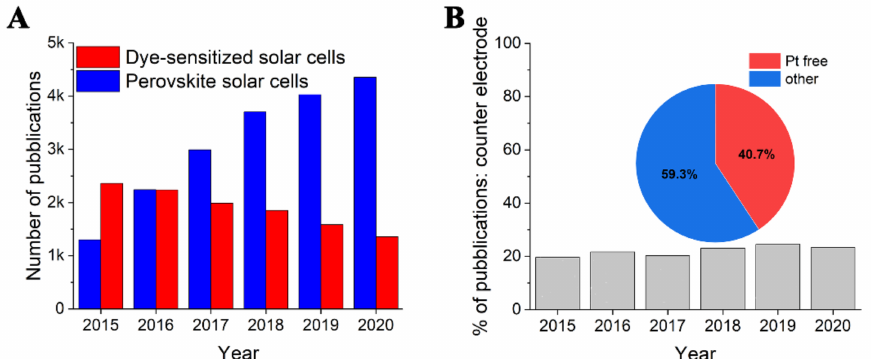
Figure 1. ( A ) Number of published articles by keyword search: dye-sensitized solar cells” and “perovskite solar cells” from 2015 to 2020. ( B ) Percentage of publications including the keyword search “counter electrode” in the topic “dye-sensitized solar cell”; inset is the share distribution of publications for counter electrodes from 2015 to 2020. Source: ISI Web of Science, Thomson